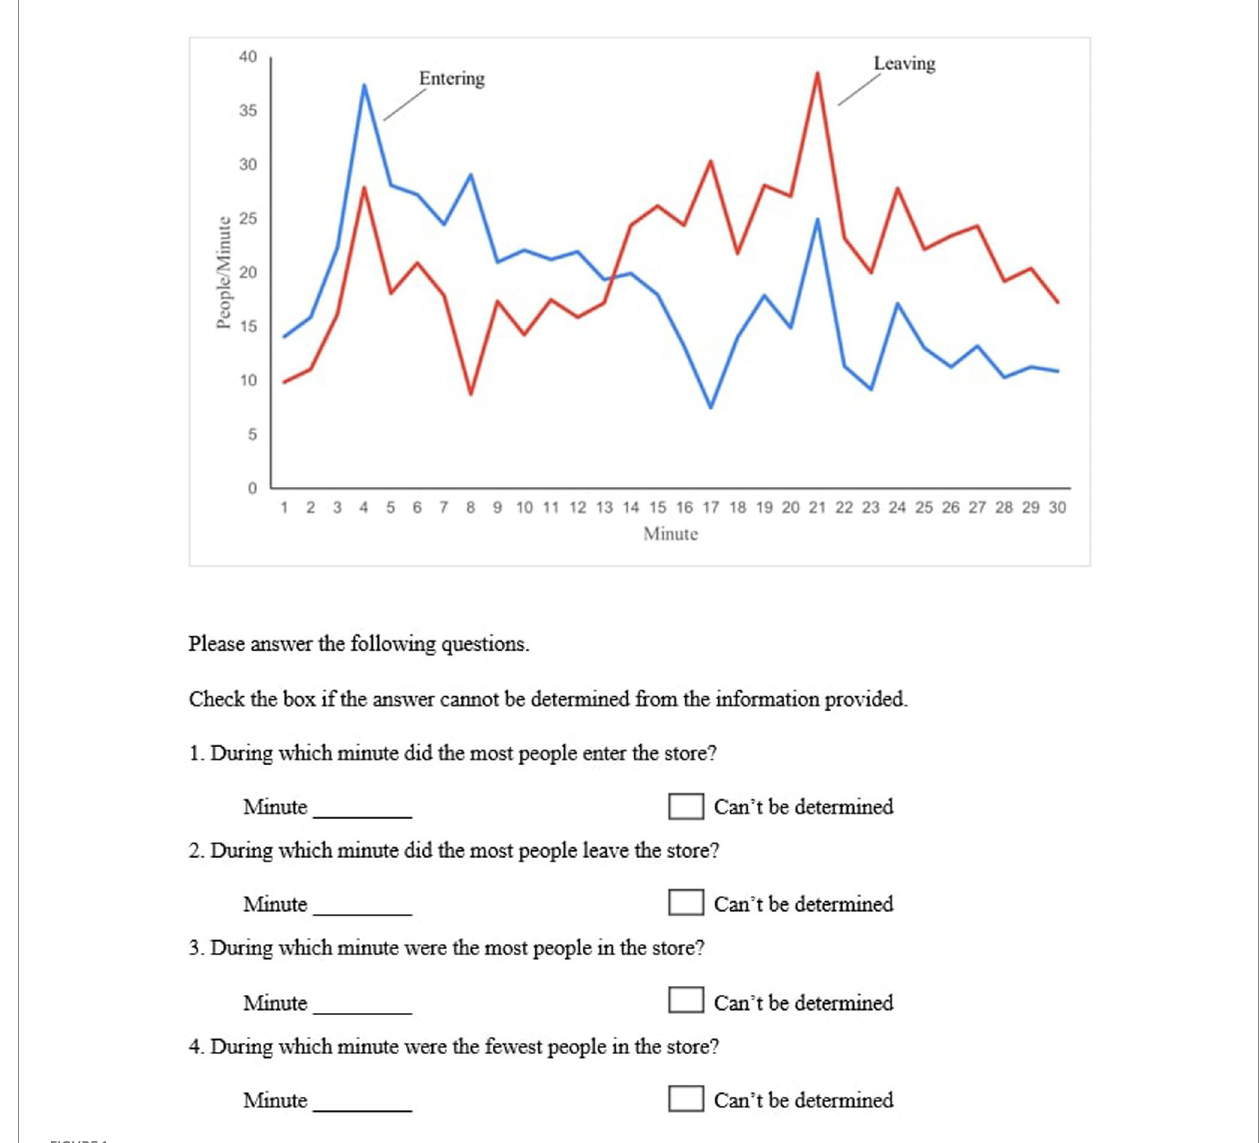
FIGURE 1 The graph and the corresponding questions are given in task